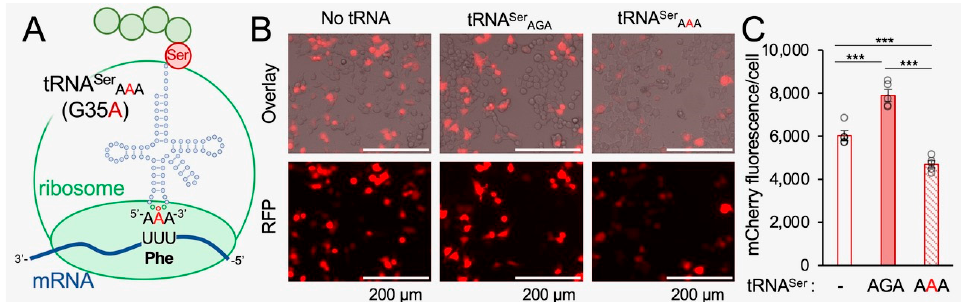
Figure 1. mCherry production in neuroblastoma cells expressing wild-type or mistranslating tRNAs. ( A ) The human tRNA SerAGA G35A mutation creates a tRNA SerAAA variant that mistranslates Phe codons with Ser in mammalian cells [17]. N2a cells were transfected with a plasmid bearing no additional tRNA, tRNA SerAGA , or tRNA SerAAA and mCherry. ( B ) Images of fluorescing cells (bright field overlay, top) were captured by live-cell fluorescence microscopy (RFP; ex. 531 nm, em. 593 nm, bottom) at 24 h after transfection. ( C ) The mCherry fluorescence per cell was quantitated (see Supplementary Appendix). Error bars represent the mean ± 1 standard deviation of at least four biological replicates. Significant differences from pairwise independent sample t-tests are indicated (*** p < 0.001).